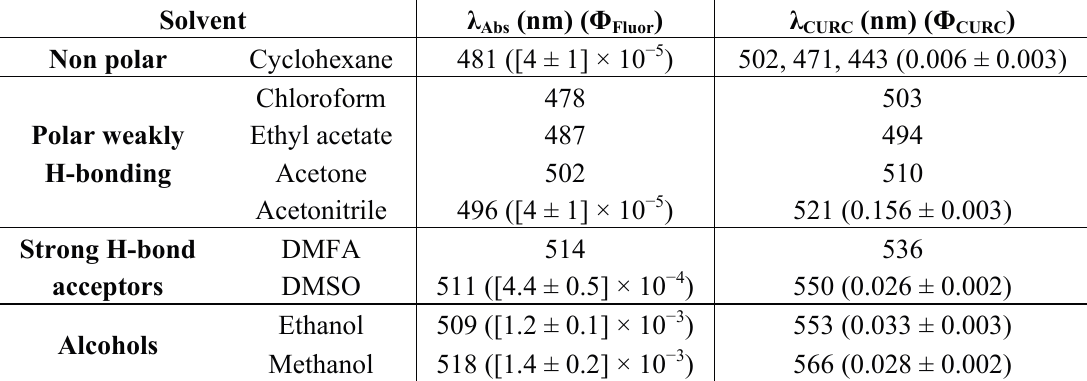
Table 3. Fluorescence emission maxima of CYV and CURC in selected solvents. Excitation @ λ . Abs